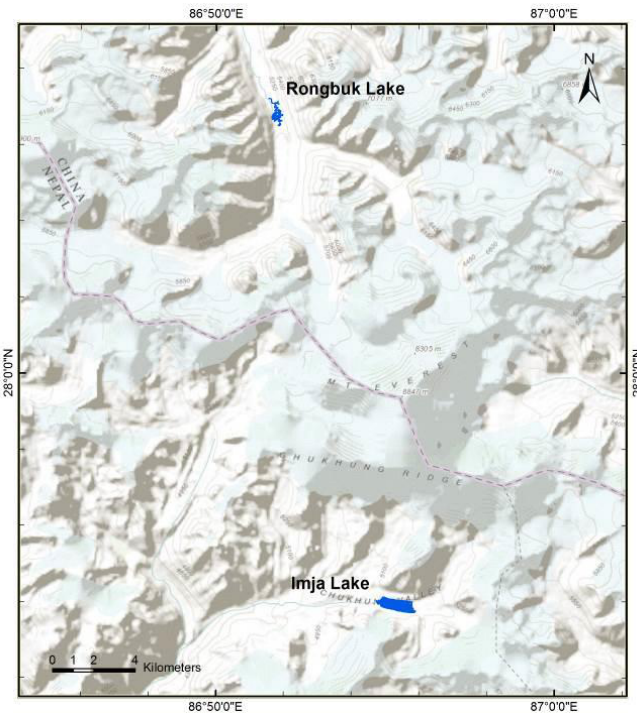
Figure 1 Rongbuk Lake and Imja Lake in Mt. Everest region, Himalaya (Basemap source: